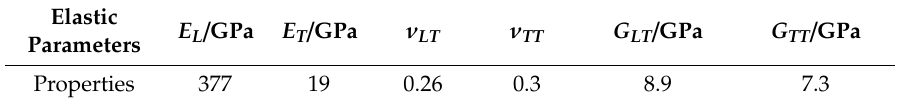
Table 5. Elastic constants of the graphite fiber.